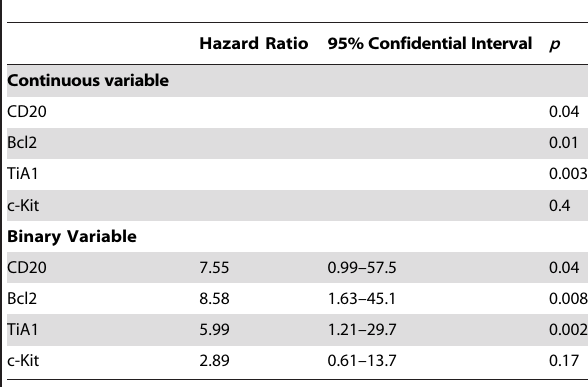
Table 2. Multivariate analysis of immunohistochemical